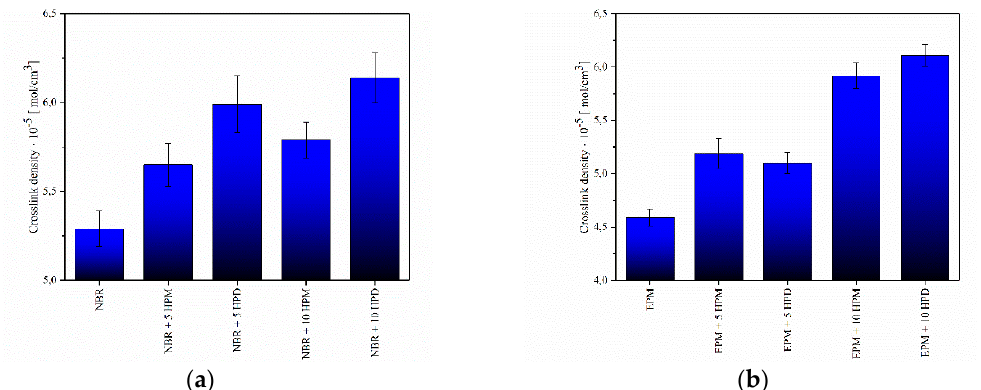
Figure 9. Crosslink density of ( a ) NBR and ( b ) EPM compounds filled with hybrid pigments.